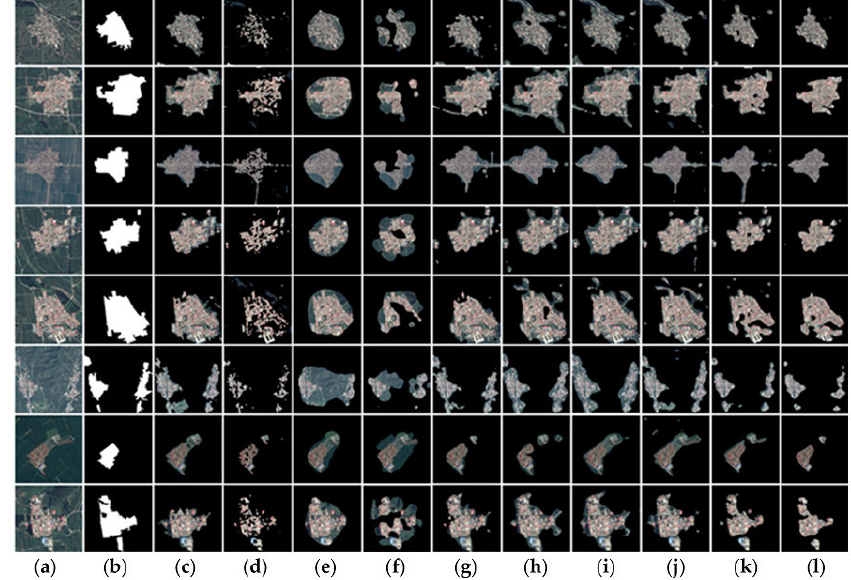
Figure 8. ROIs extracted by our proposed model and nine competing models on Google Earth images. ( a ) Origin images; ( b ) Ground truth; ( c ) CA; ( d ) FT; ( e ) GBVS; ( f ) ITTI; ( g ) WT; ( h ) SR; ( i ) MFF; ( j ) SACH; ( k ) FDA and ( l )